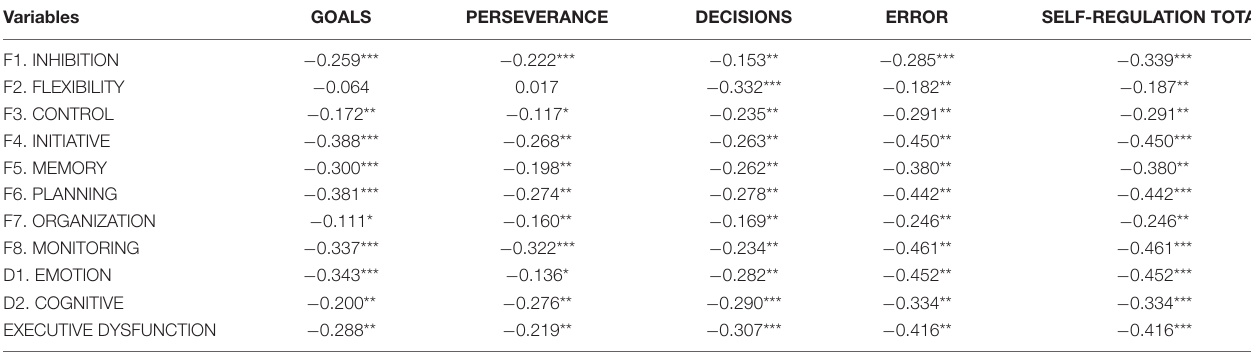
TABLE 2 | Bivariate correlations between self-regulation (SR) and executive functions (EFs).